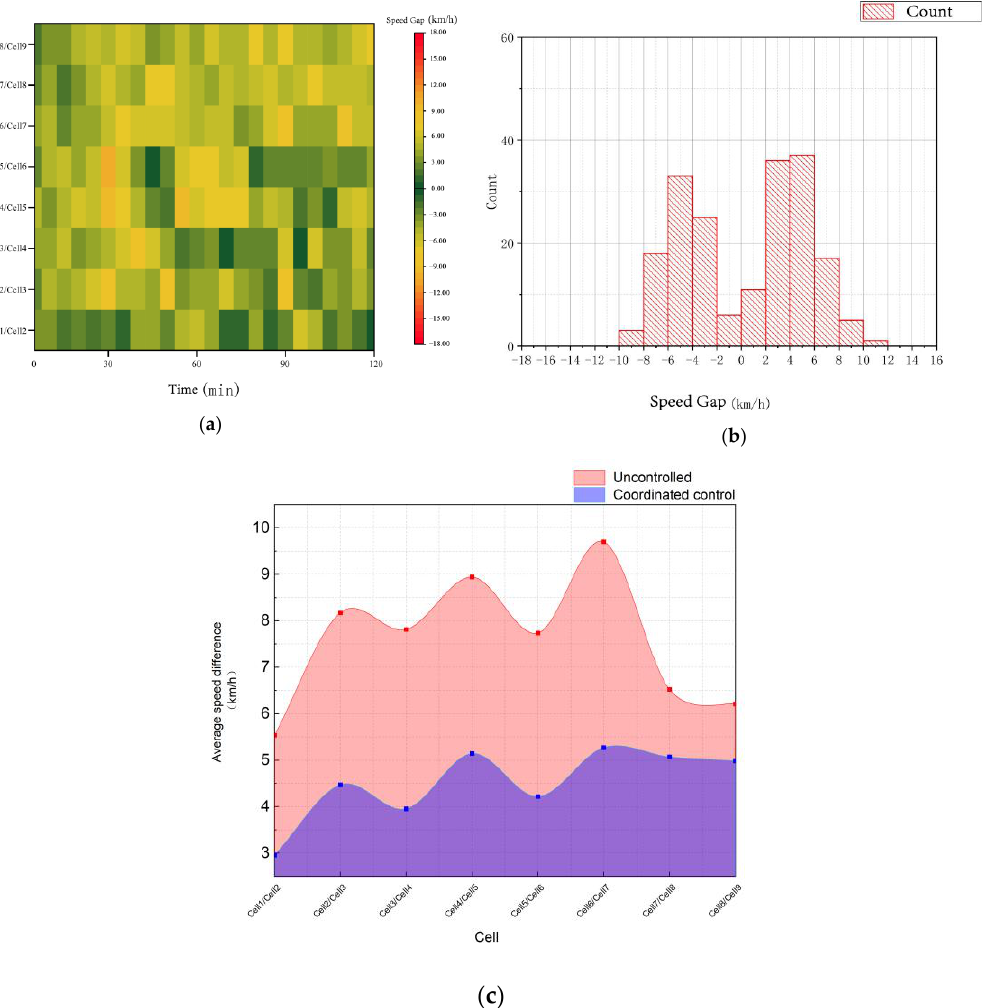
Figure 22. Spatial speed difference under coordinated control. ( a ) Spatial Speed Difference under coordinated control; ( b ) Spatial Speed Difference Distribution Histogram under coordinated control; ( c ) Comparison of average speed difference under uncontrolled and coordinated control.